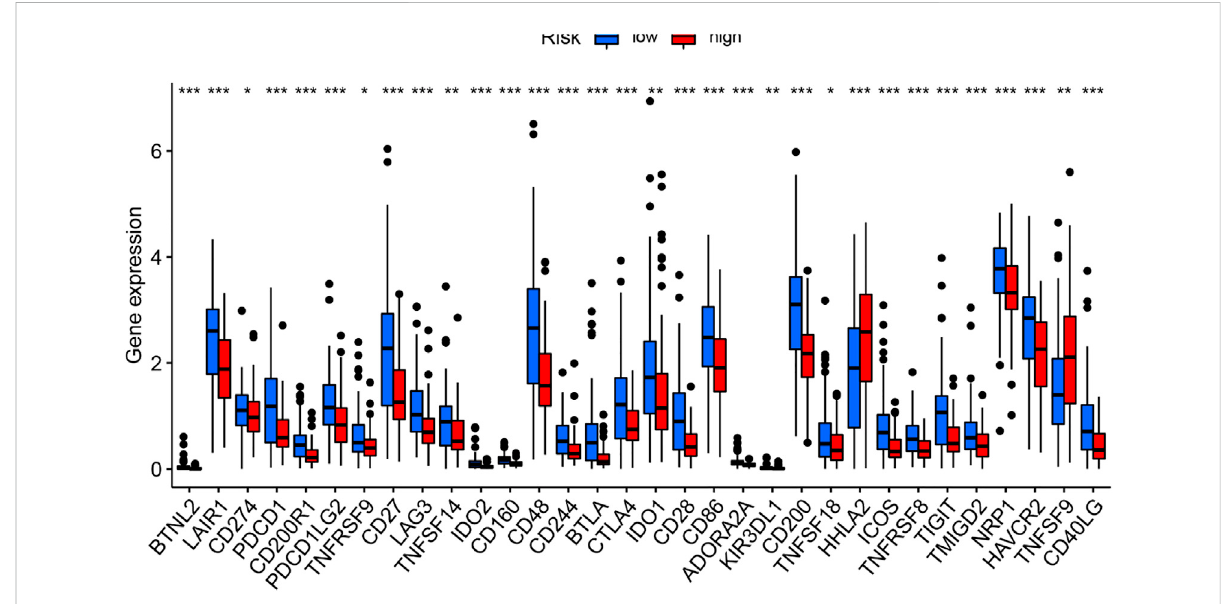
FIGURE 13 Comparison of 32 immune checkpoint blockade – related gene expression levels in low-/high-risk